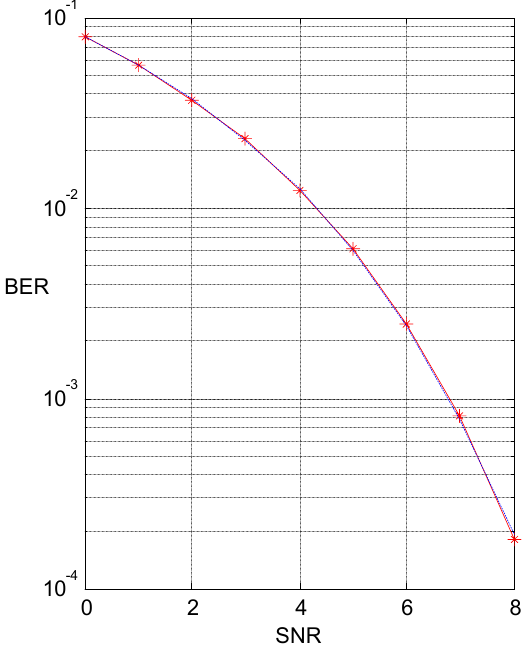
Figure 2. BER curves for a single-correlator receiver in presence of additive white Gaussian noise channel (AWGN): theory (blue) and simulation